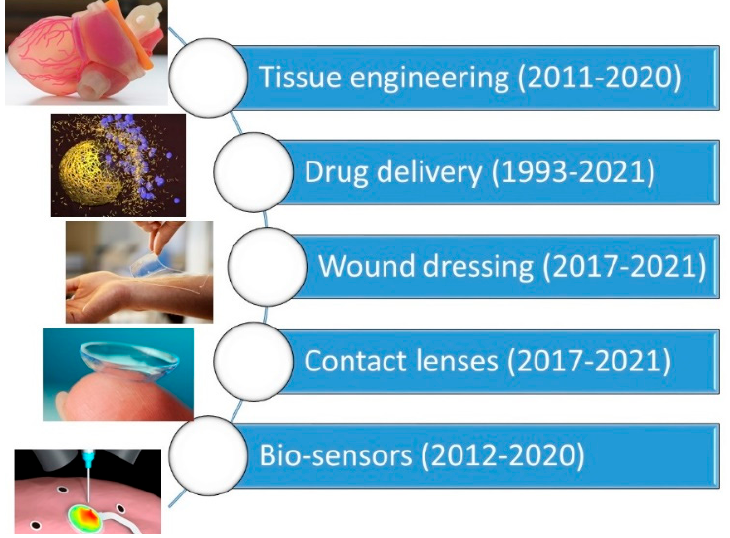
Figure 4. Schematic display of common hydrogel applications and the publication years of compre- hensive reviews relevant to each application. Table 1. Number of reviews and publication periods on different hydrogel applications in biomedi- cal